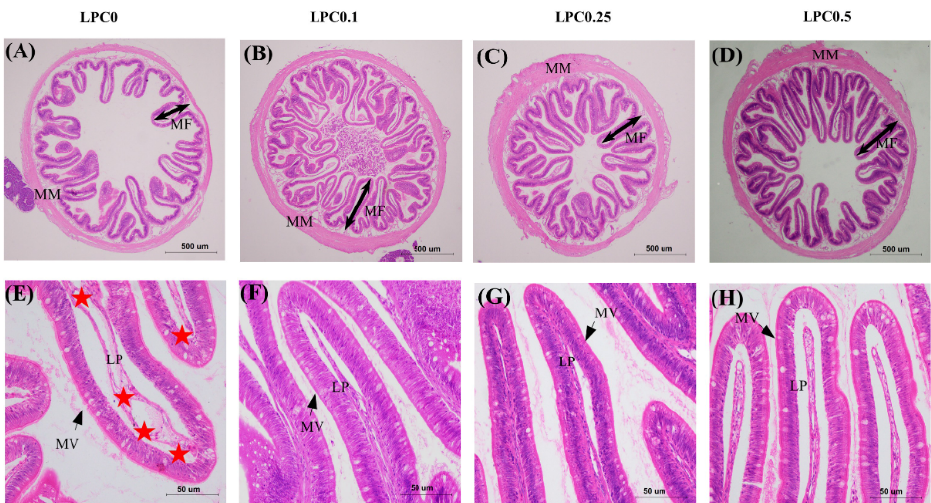
Figure 1. Histological sections of the distal intestine in four experimental groups. Scale bar = 500 μ m for ( A – D ), and scale bar = 50 μ m for ( E – H ). Staining: H & E. Red stars showed the infiltration of mixed leucocytes in the lamina propria (LP). MF mucosal folds. MM muscularis mucosa. MV microvilli (black arrows).